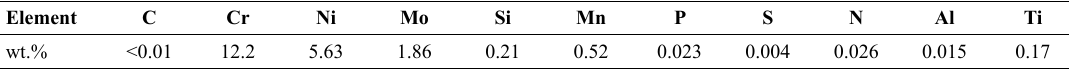
Table 1. Chemical analysis of the supermartensitic stainless steel. Element C Cr Ni Mo